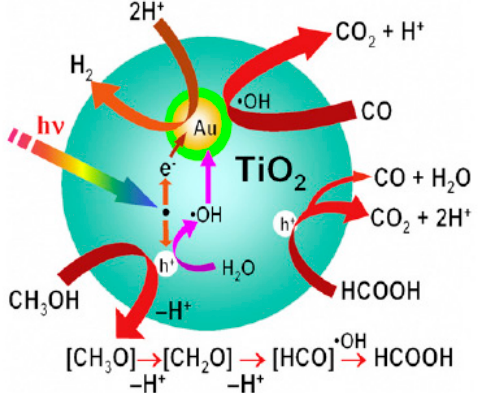
Figure 3. Reaction pathways of photocatalytic reforming of methanol on Au/TiO 2 catalyst (Adapted from Ref. [36]).